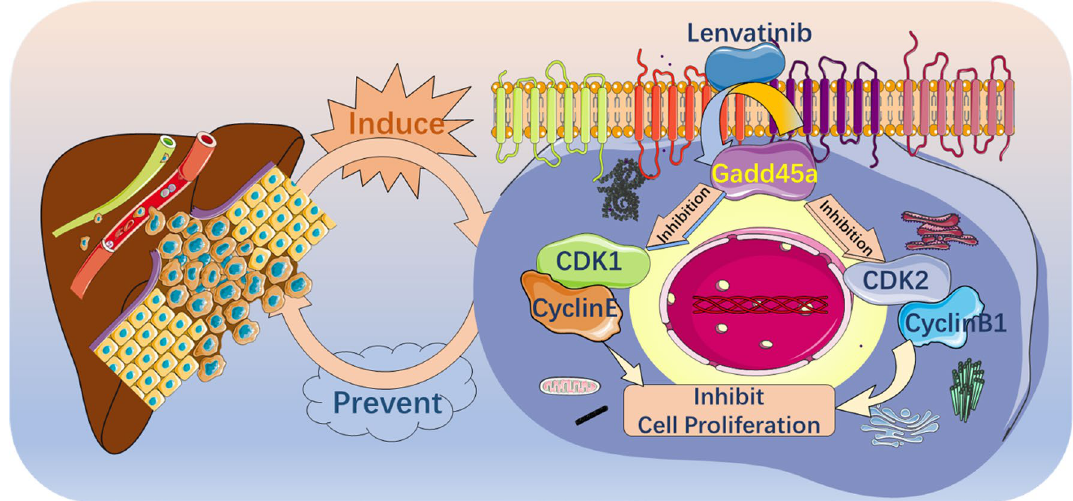
Fig. 6 The possible mechanism of lenvatinib in